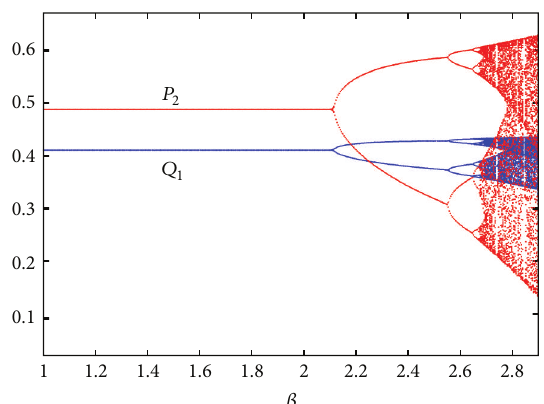
Figure 6: Bifurcation diagrams of system (10) for 𝛼 = 2.5 and 𝛽 varying from 1.0 to 2.47 .